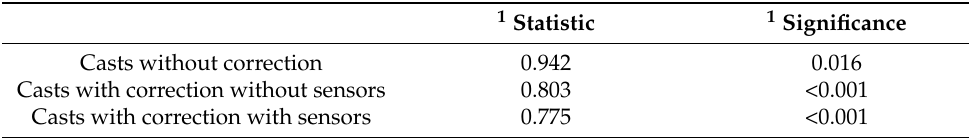
Table 2. Test of